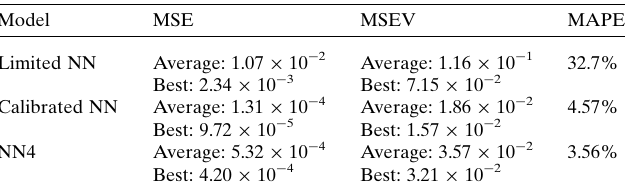
Table 5 Summarized performance of the neural networks on the measured data set. The metrics in this table are computed on the scaled predicted values which lie in the range (cid:2) 1 to 1. The Limited NN model was trained using bench-based magnetic measurement data. The NN4 model was trained using simulated data. The Calibrated NN used NN4 as a base model and was then updated using the measured data via transfer learning.